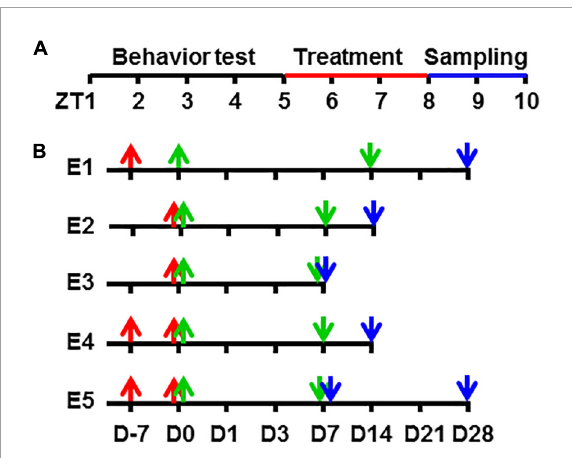
FIGURE1 A schematic diagram of experimental procedures in zeitgeber time and time points. Showing the zeitgeber time of procedures (A) and the time points in each experimental group (B) in this study. ZT, zeitgeber time in hour [ZT0, light turn on time (7 AM)]. D, time in day; E1, Experiment 1; E2, Experiment 2, and so on.